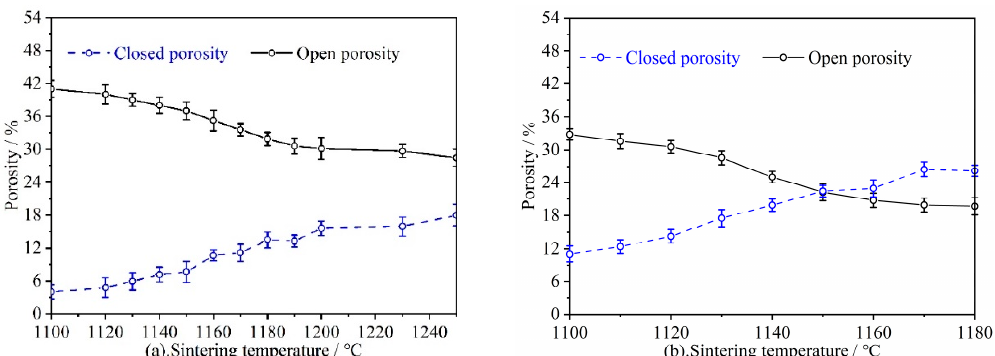
Figure 5. Porosity and flexural strength of ( a ) SS and ( b ) RS series samples at different sintering temperatures.